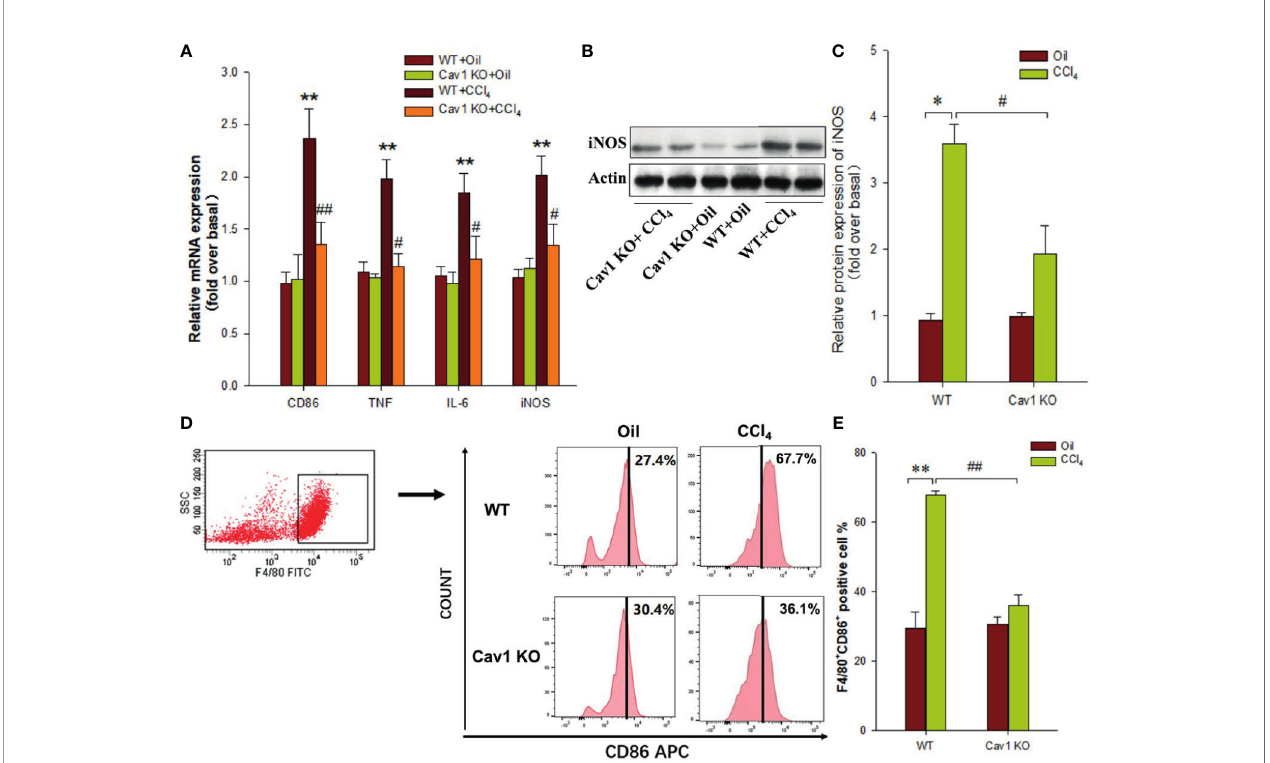
FIGURE 5 | Cav1 de fi ciency reduced hepatic macrophages polarization toward M1 phenotype in injured Liver. Mouse primary hepatic macrophages were isolated from Cav1 KO and WT mice treated with olive oil or CCl 4 for one week. (A) The mRNA levels of M1 markers (i.e. CD86, TNF, IL-6, and iNOS) were detected by RT- PCR. (B) The protein expressions of iNOS (M1 marker) were measured by Western blot. (C) Histogram showing densitometry analysis and quanti fi cation of iNOS. (D) FCM was performed to detect M1 macrophages. (E) Quanti fi cation of the proportion of M1 macrophages. Data are shown as mean ± SD, * p < 0.05, ** p < 0.01 compared with the WT+oil group; # p < 0.05, ## p < 0.01 compared with the WT+CCl 4 group. n=6 per